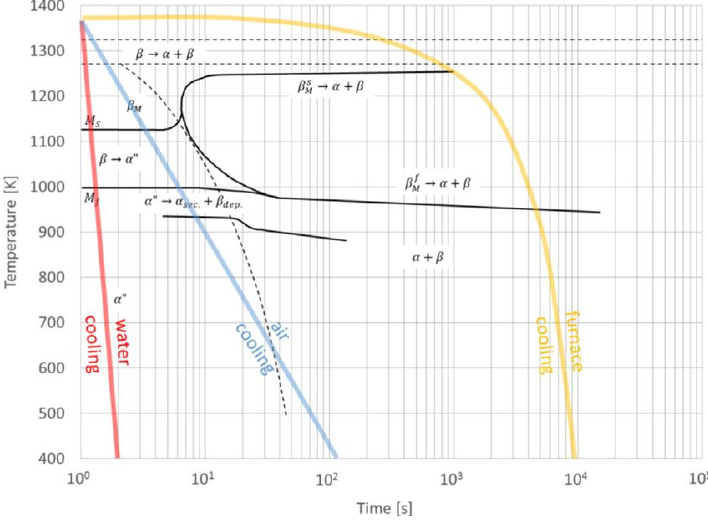
Figure 3. Continuous Cooling Transformation (CCT) diagram for Ti6Al4V. The three colorful curves represent the thermal profiles of water, air and furnace cooling(adapted from